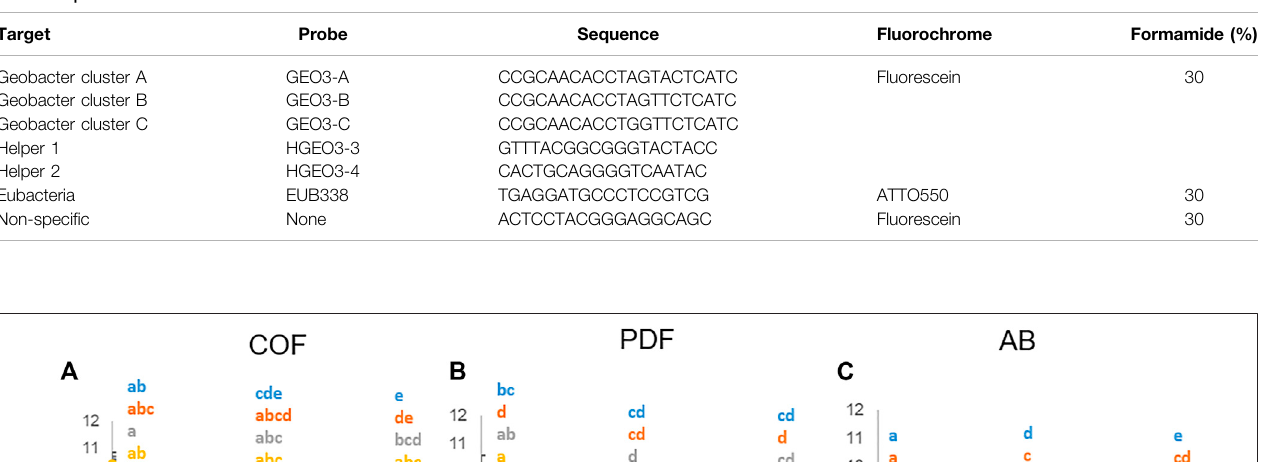
Frontiers in Environmental Science |